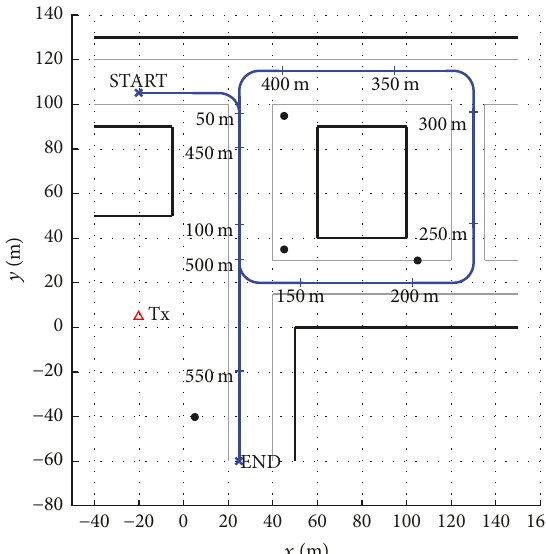
Figure 6: The simulation scenario with thick black lines represent- ing reflecting walls and black circles representing objects that scatter the RF signals. The physical transmitter is marked by the red upward triangle labeled Tx. The user travels along the blue line from START to END with one loop around the central building.